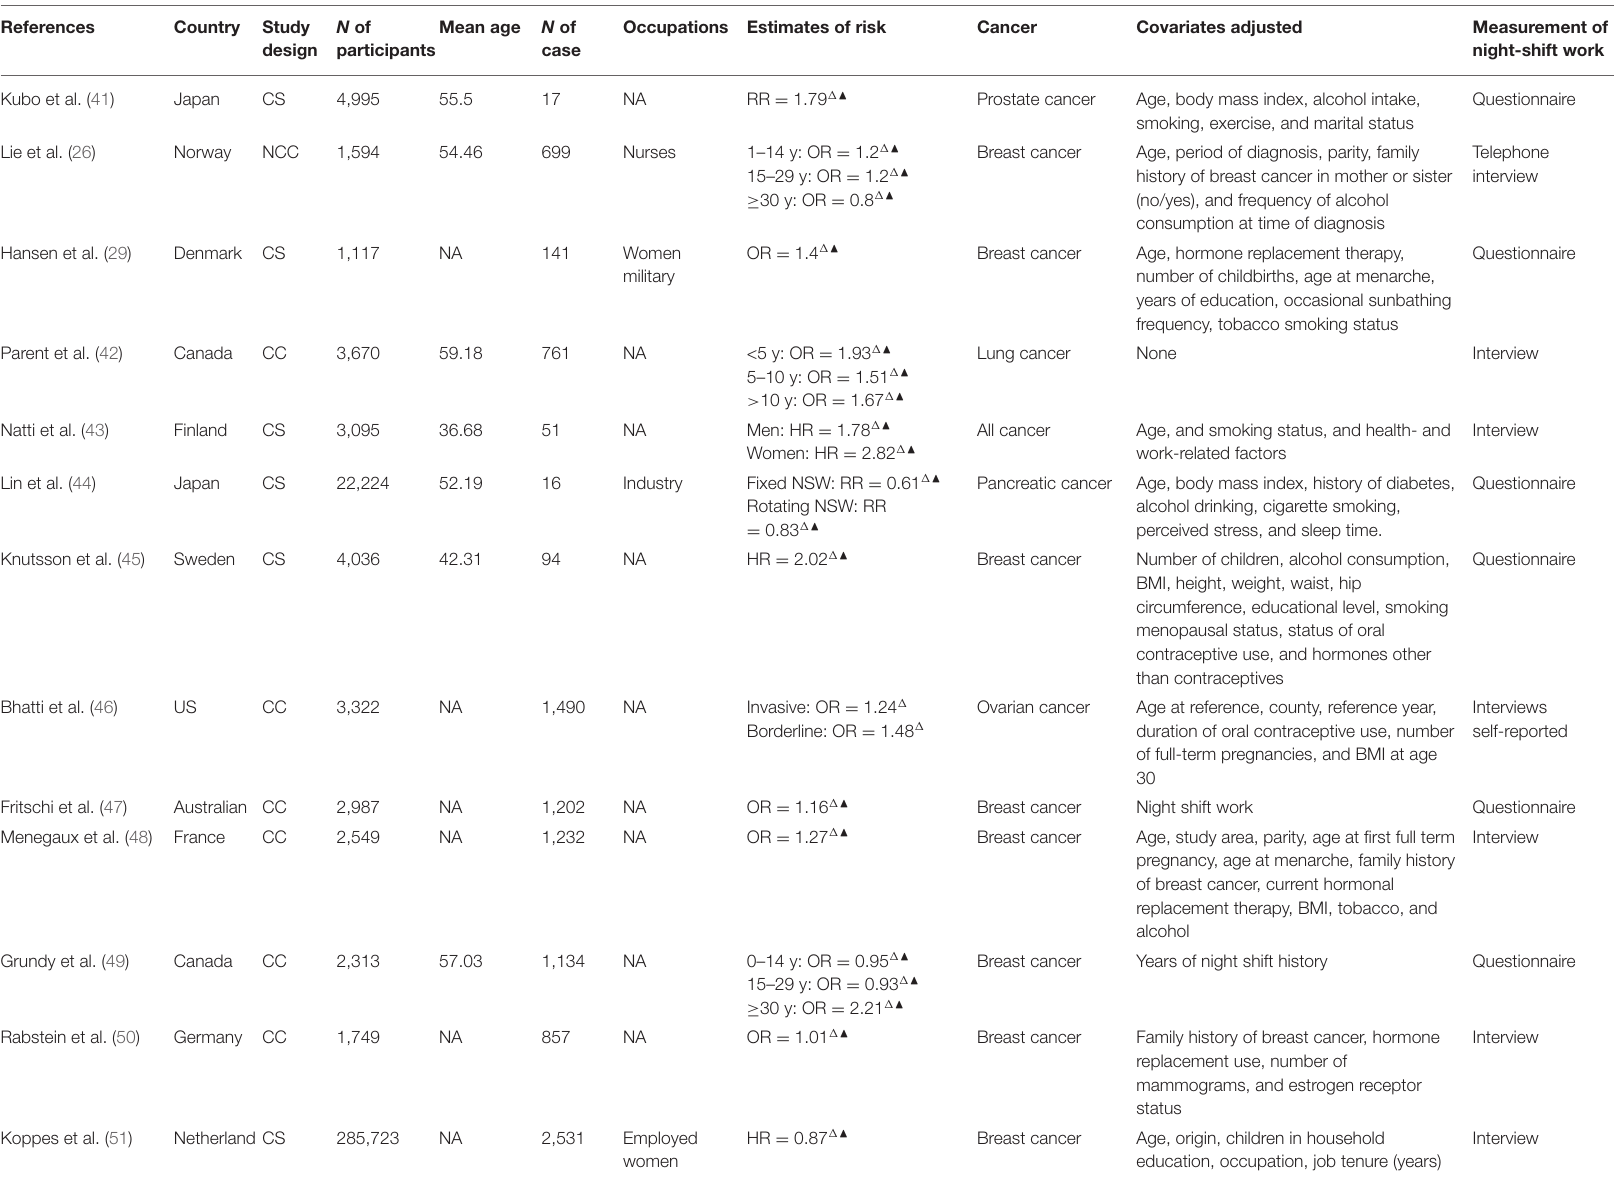
Breast cancer Age, study area, parity, age at first full term pregnancy, age at menarche, family history of breast cancer, current hormonal replacement therapy, BMI, tobacco,